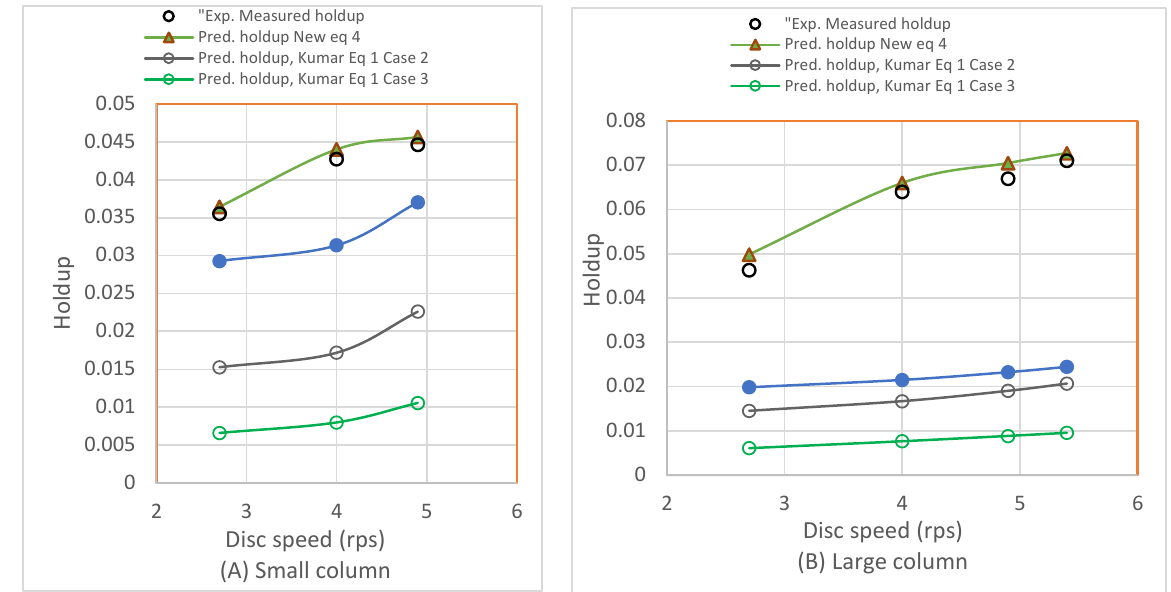
Figure 12. Measured and predicted holdup data for the new and the reported correlations (dots represent the measured holdup). ( A ) For the small column (flowrate = 7.759 cm 3 /s, distributor = 0.15 cm) and ( B ) the large column (flowrate = 80.3 cm 3 /s, distributor = 0.12 cm).